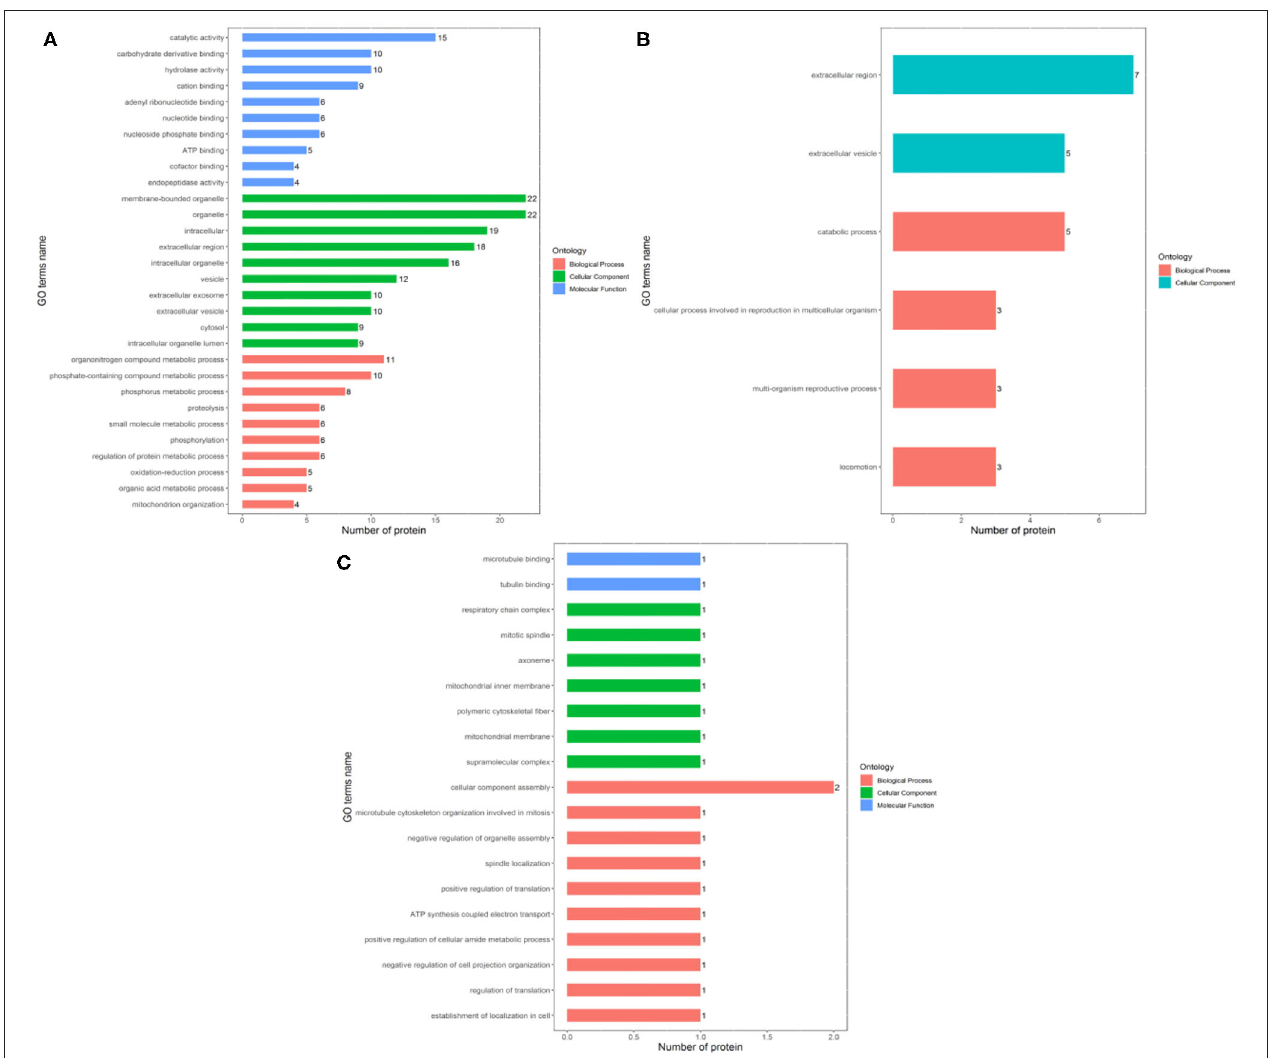
FIGURE 3 | Biological process, cellular component, and molecular function of differentially expressed proteins. (A) between Fresh and Cryo–AFP groups; (B) between Fresh and Cryo + AFP groups; (C) between Cryo–AFP and Cryo + AFP groups. The value represents the number of differential proteins.